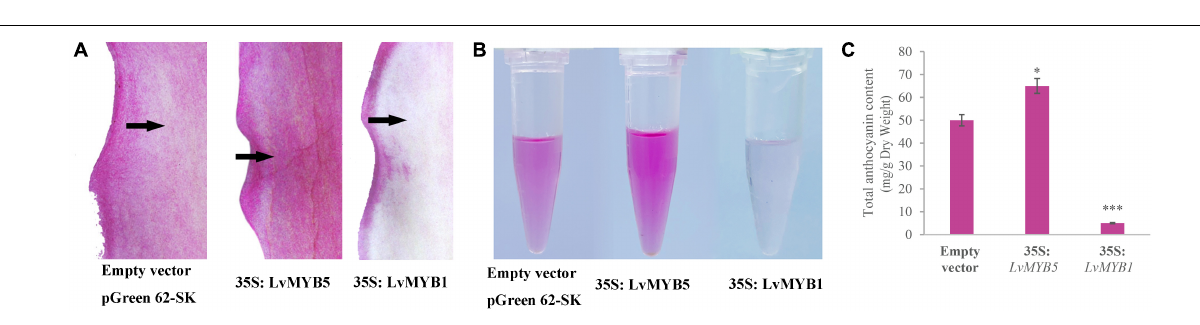
FIGURE 5 | Transient overexpression of LvMYB5 and LvMYB1 in lily petals. (A) Transient overexpression changes the color of lily petals. (B) Extraction of total anthocyanins from lily petals after treatment. (C) Determination of total anthocyanin content in lily petals ( ∗ p ≤ 0.1, ∗∗∗ p ≤